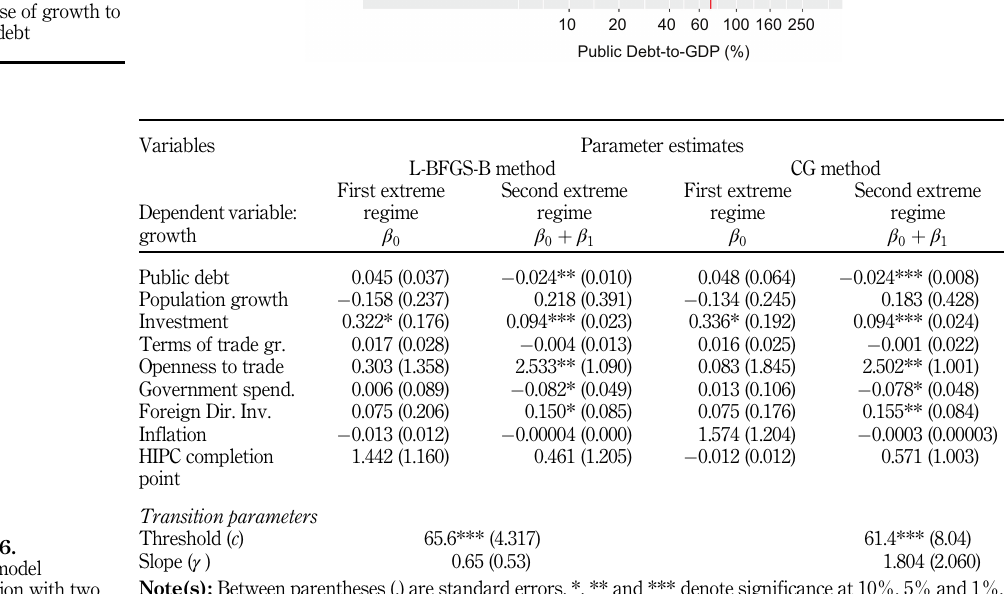
Figure 2. Response of growth to public debt